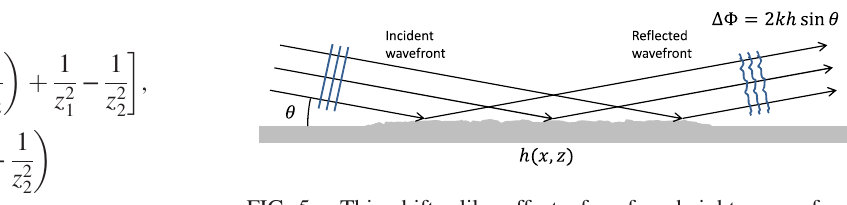
FIG. 5. Thin-shifter-like effect of surface height errors for a small mean square of surface displacement, concept adapted from